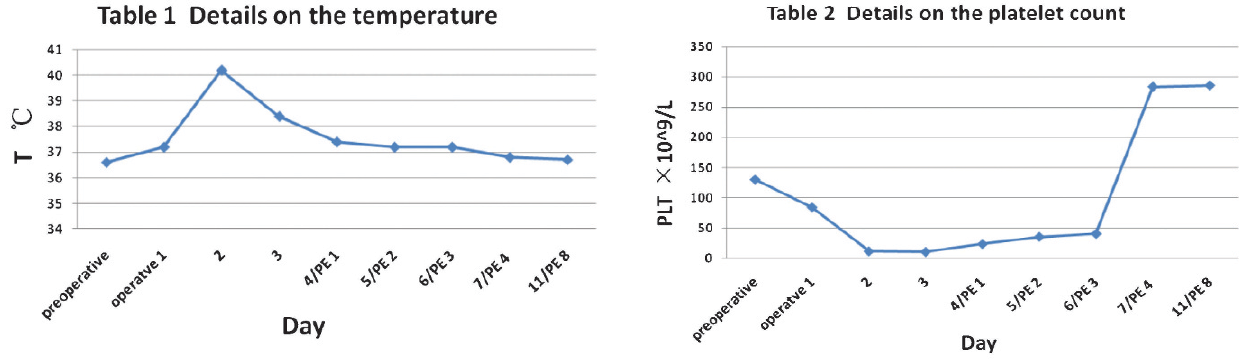
Table 2 - Patient platelet counts over the course